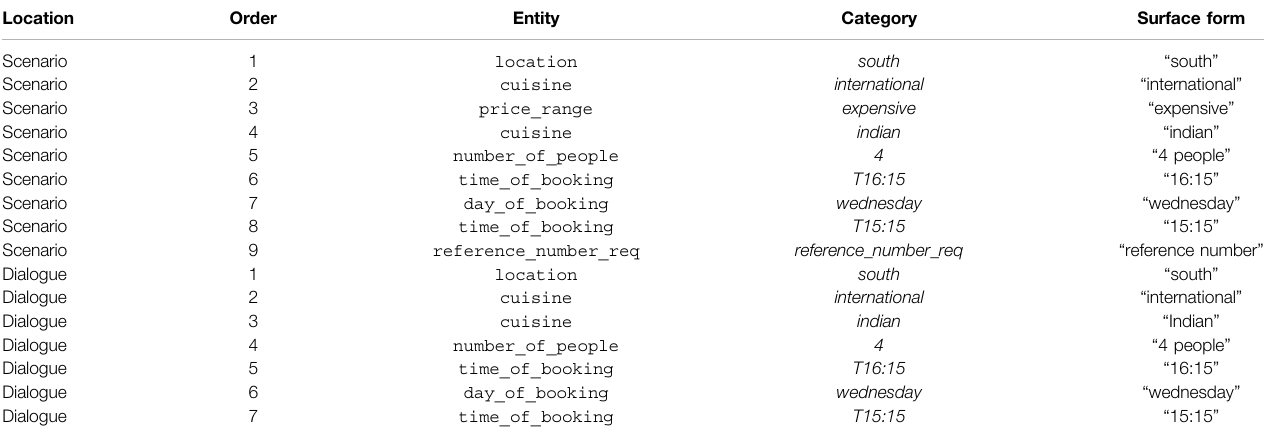
TABLE 2 | Entities in scenario and dialogue of MultiWOZ example